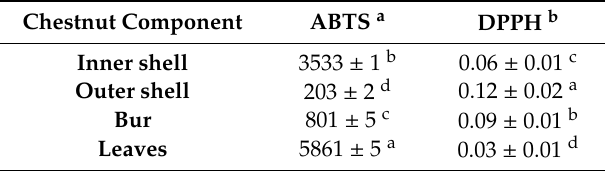
Table 3. Antioxidant activity of the inner and outer shells, bur, and leaves of chestnut (mean value ± SD, n =